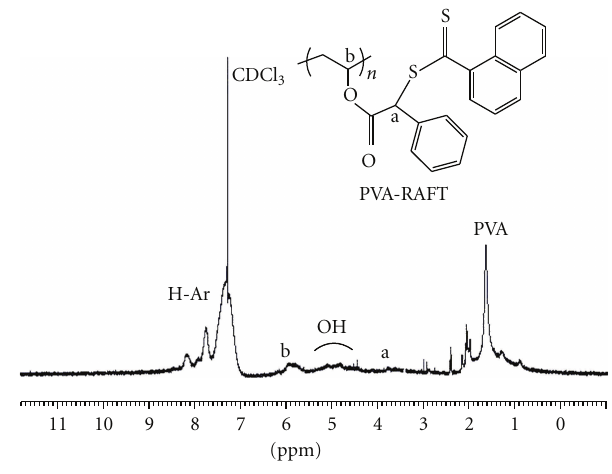
Figure 5: 1 H-NMR spectrum of PVA-RAFT.